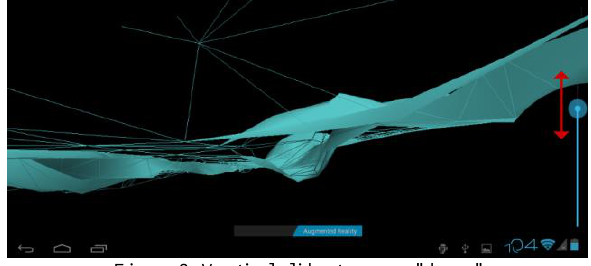
Figure 8: Vertical slider to zoom